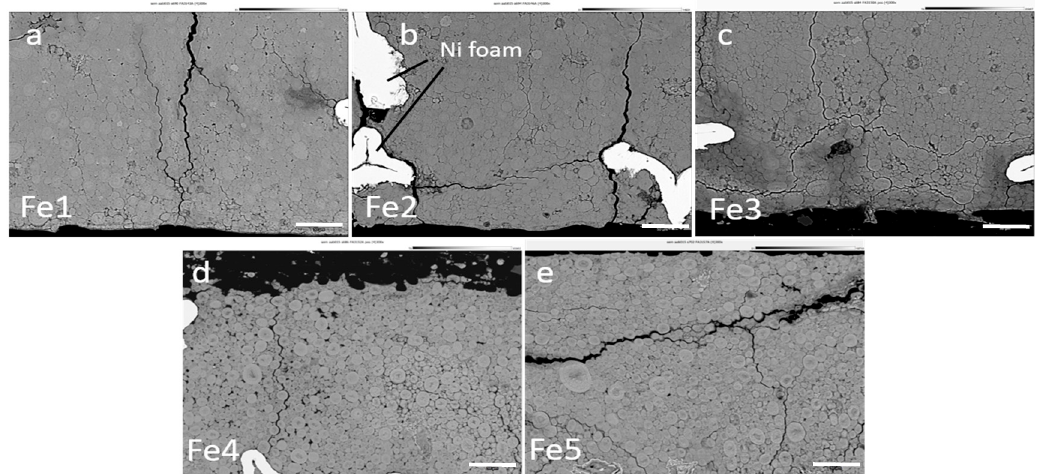
Figure 6. SEM micrographs of the positive electrodes of cells ( a ) Fe1, ( b ) Fe2, ( c ) Fe3, ( d ) Fe4 and ( e ) Fe5 after cycle life testing at RT. Magnification: 300×. The scale bar (white) represents 50 µm. The bright white regions in ( b ), ( c ) and ( d ) are the Ni-foam current collectors.